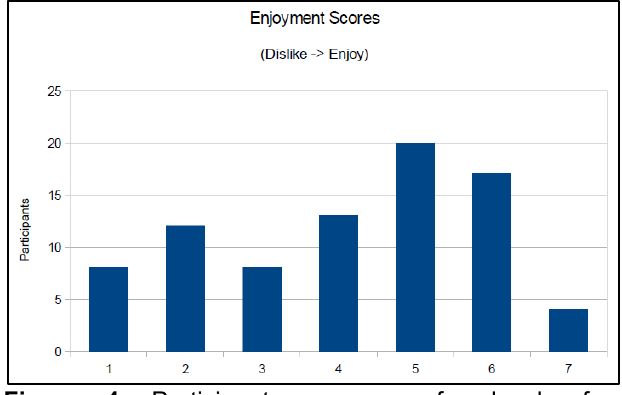
Figure 4. Participant responses for level of